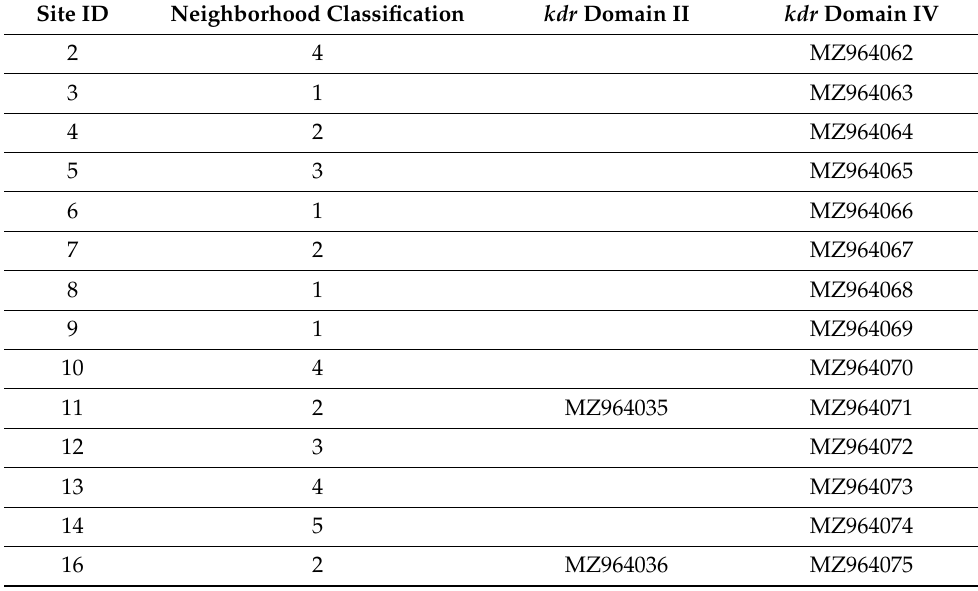
Table A2. Accession Numbers for kdr Domains II and